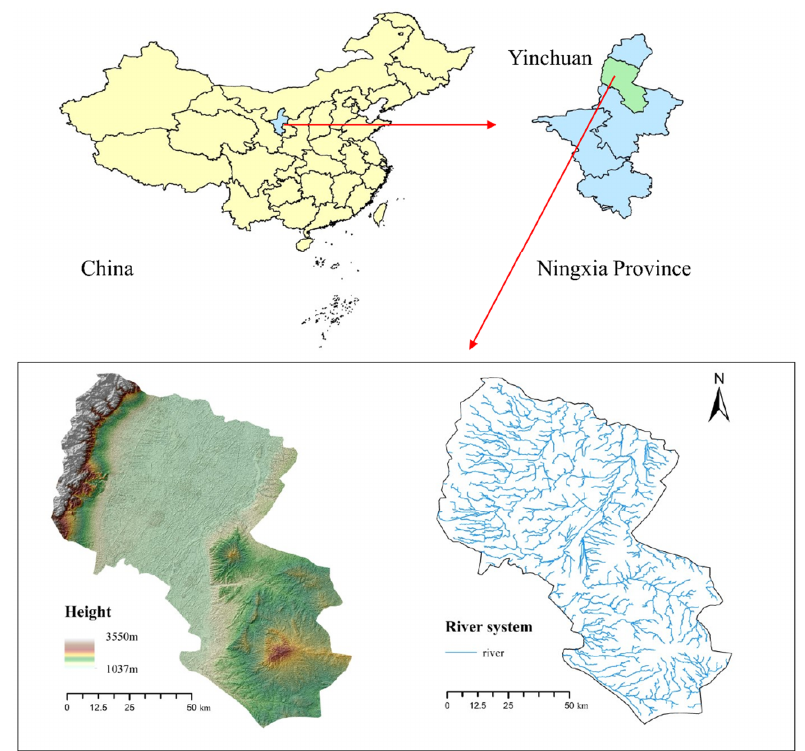
Figure 1. Overview map of the location, terrain, and water system in Yinchuan.